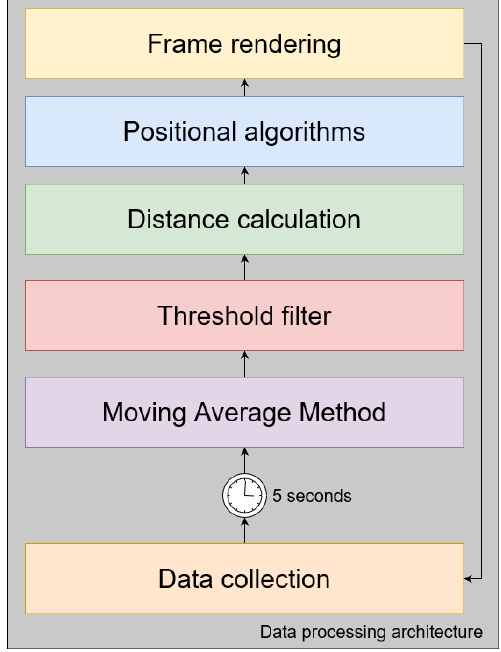
Figure 2. Data processing